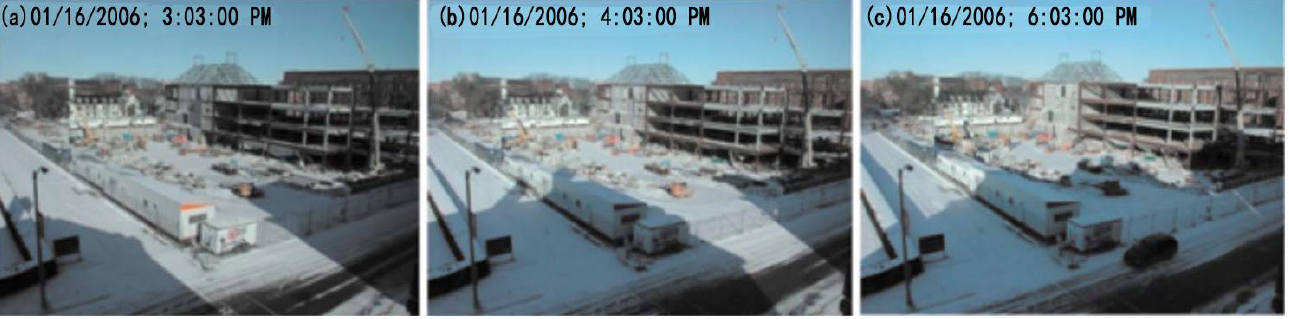
Figure 11. Effect of shadow on a single working day: (a) 3:00 PM ; (b) 4:00 PM; (c) 6:00 PM [33].